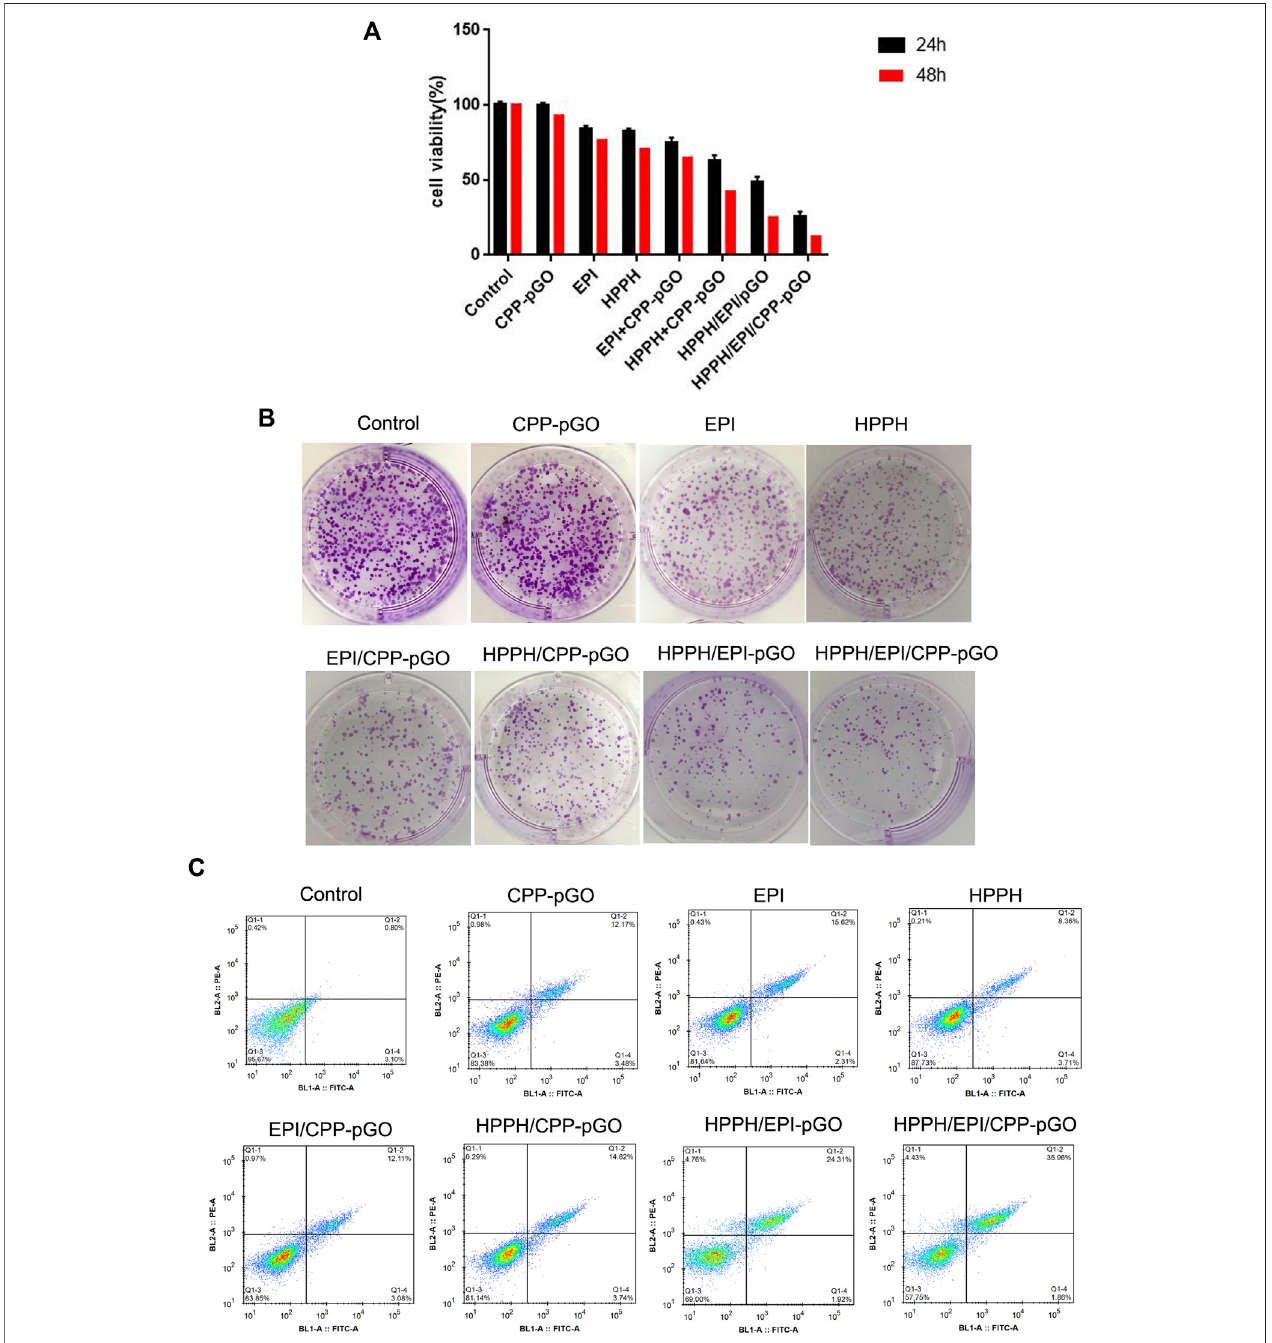
FIGURE 3 | HPPH/EPI/CPP-pGO inhibited proliferation and colony formation of MG-63 cancer cells. (A) Cell viability of MG-63 cells treated with PBS (control), CPP-pGO, EPI (10 μ g/mL), HPPH (1 μ M), HPPH/CPP-pGO (containing 1 μ M of HPPH), EPI/CPP-pGO (containing 10 μ g/mL of EPI), HPPH/EPI/pGO (containing 1 μ M of HPPH and 10 μ g/mL of EPI), and HPPH/EPI/CPP-pGO (containing 1 μ M of HPPH and 10 μ g/ml of EPI), respectively, for 24 and 48 h by CCK-8 assay. (B) Colony forming number of MG-63 cells treated with PBS (control), CPP-pGO, EPI, HPPH, HPPH/CPP-pGO, EPI/CPP-pGO, HPPH/EPI/pGO, and HPPH/EPI/CPP-pGO, respectively, for 24 h by colony formation assay. (C) Cell apoptosis rateofU87 MG cells treated with PBS(control), CPP-pGO, EPI, HPPH, HPPH/CPP-pGO, EPI/CPP- pGO, HPPH/EPI/pGO, and HPPH/EPI/CPP-pGO, respectively, for 24 h by fl ow cytometry analysis.